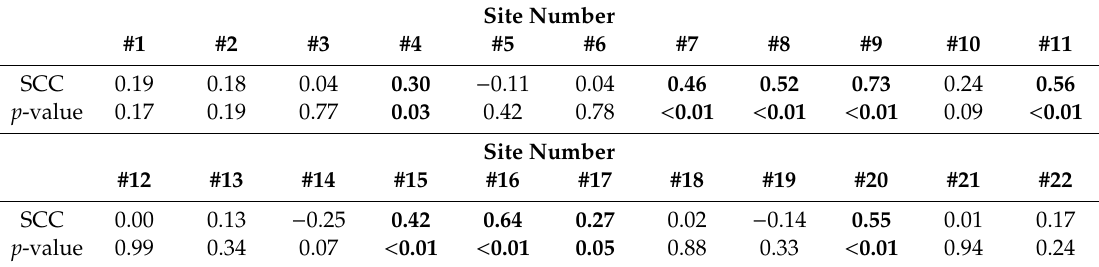
Table 4. Results of Spearman’s correlation test, including annual E. coli concentration (CFU per 100 mL) and annual SPM concentration (mg / L) at each sampling location (n = 22) during the study period (2 January 2018–1 January 2019) in West Run Watershed, WV, USA. Note: bold values indicate significant correlations ( p <